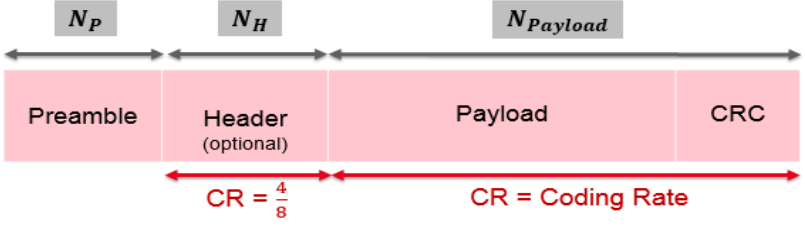
Figure 5. LoRa packet